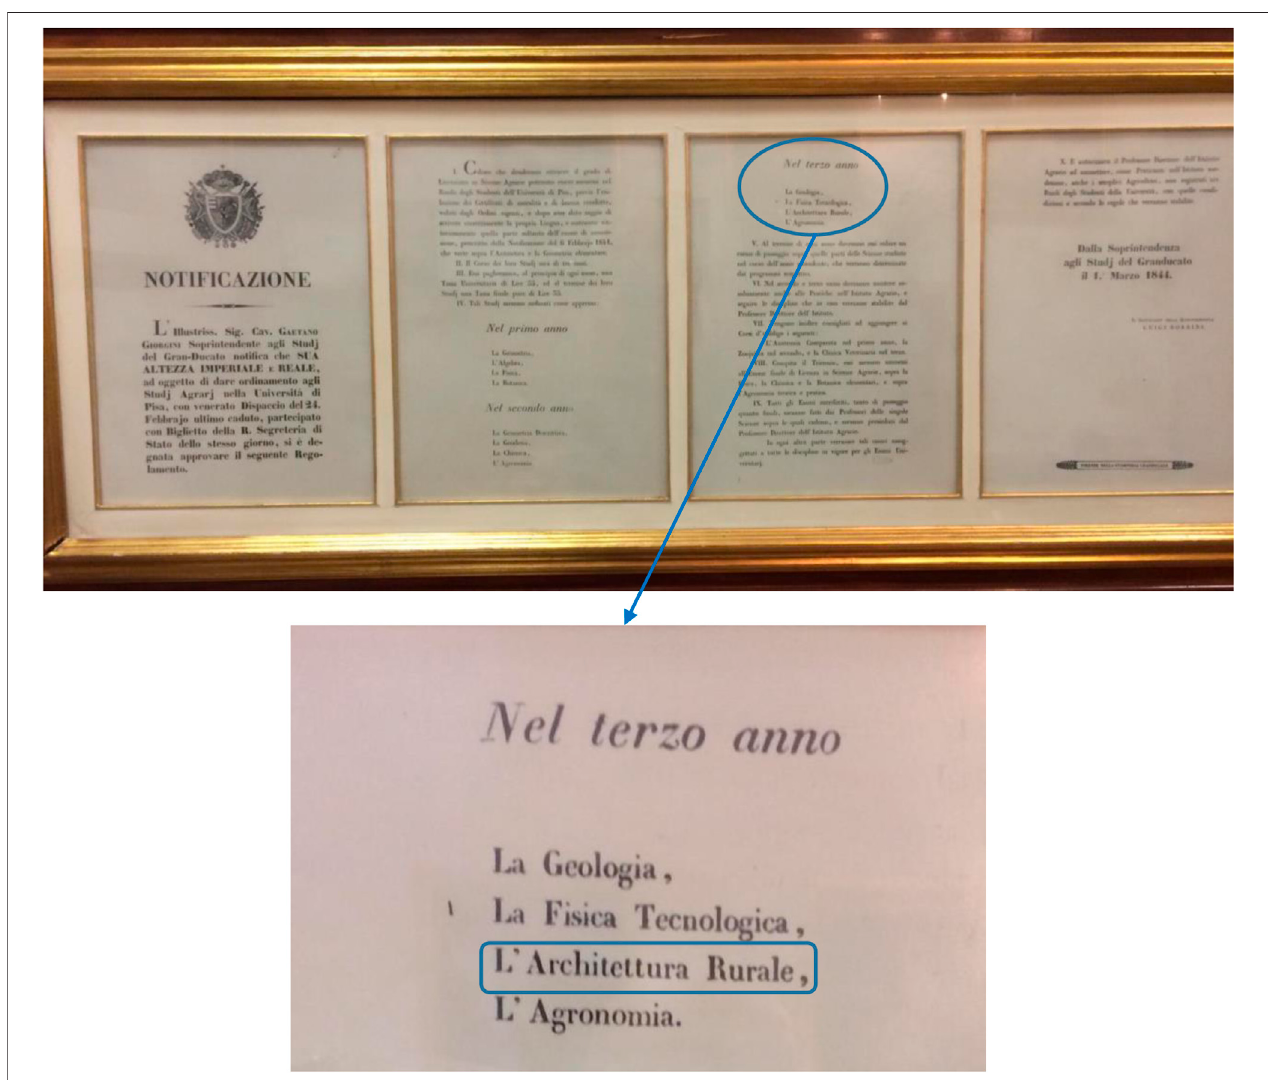
FIGURE 1 | Rules of the fi rst study course on Agricultural Studies in Italy, 1 March 1844, University of Pisa.